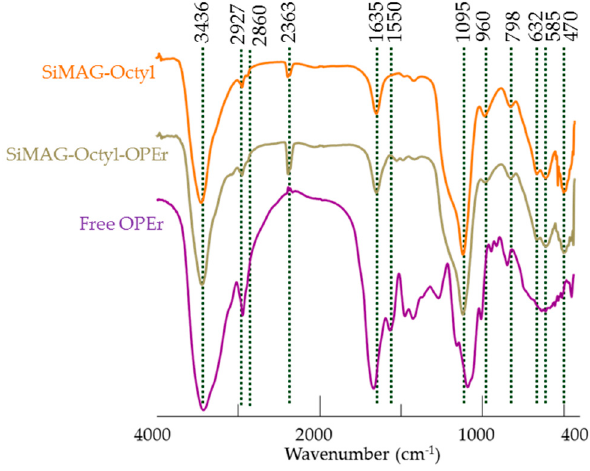
Figure 9. FTIR spectra of commercial SiMAG-Octyl carrier, OPEr immobilized to the carrier by hydrophobic attachment and free lipase OPEr.